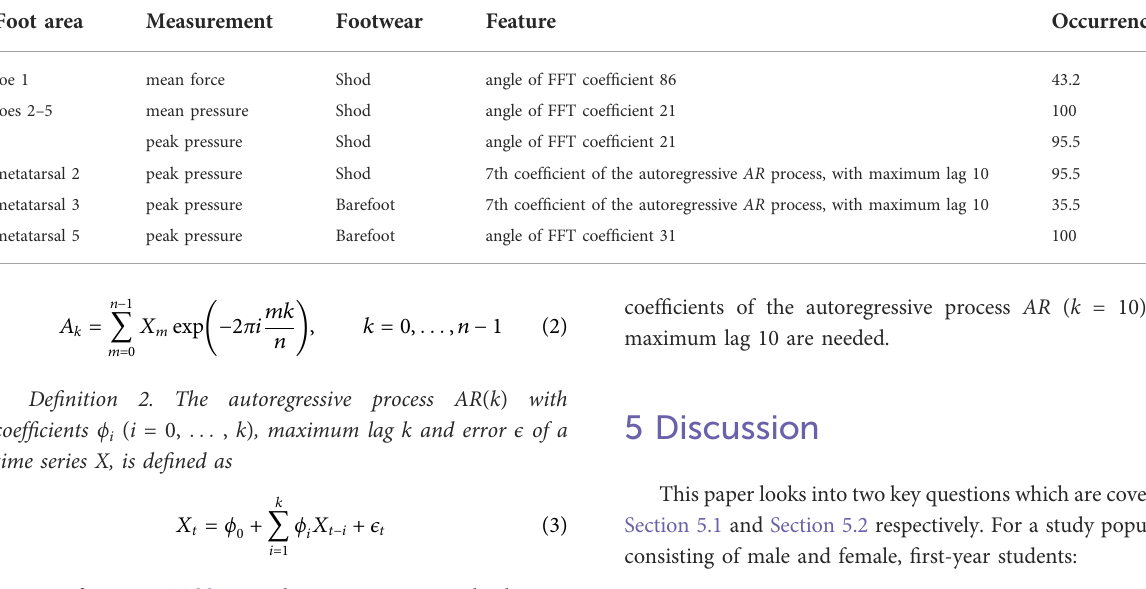
TABLE 4 Features that are present in at least 10% of the folds. The “ occurrence ” column gives the percentage of the folds where the feature was chosen by SelectKBest and the L1 regularization. De fi nition 1 and 2 further explain some used